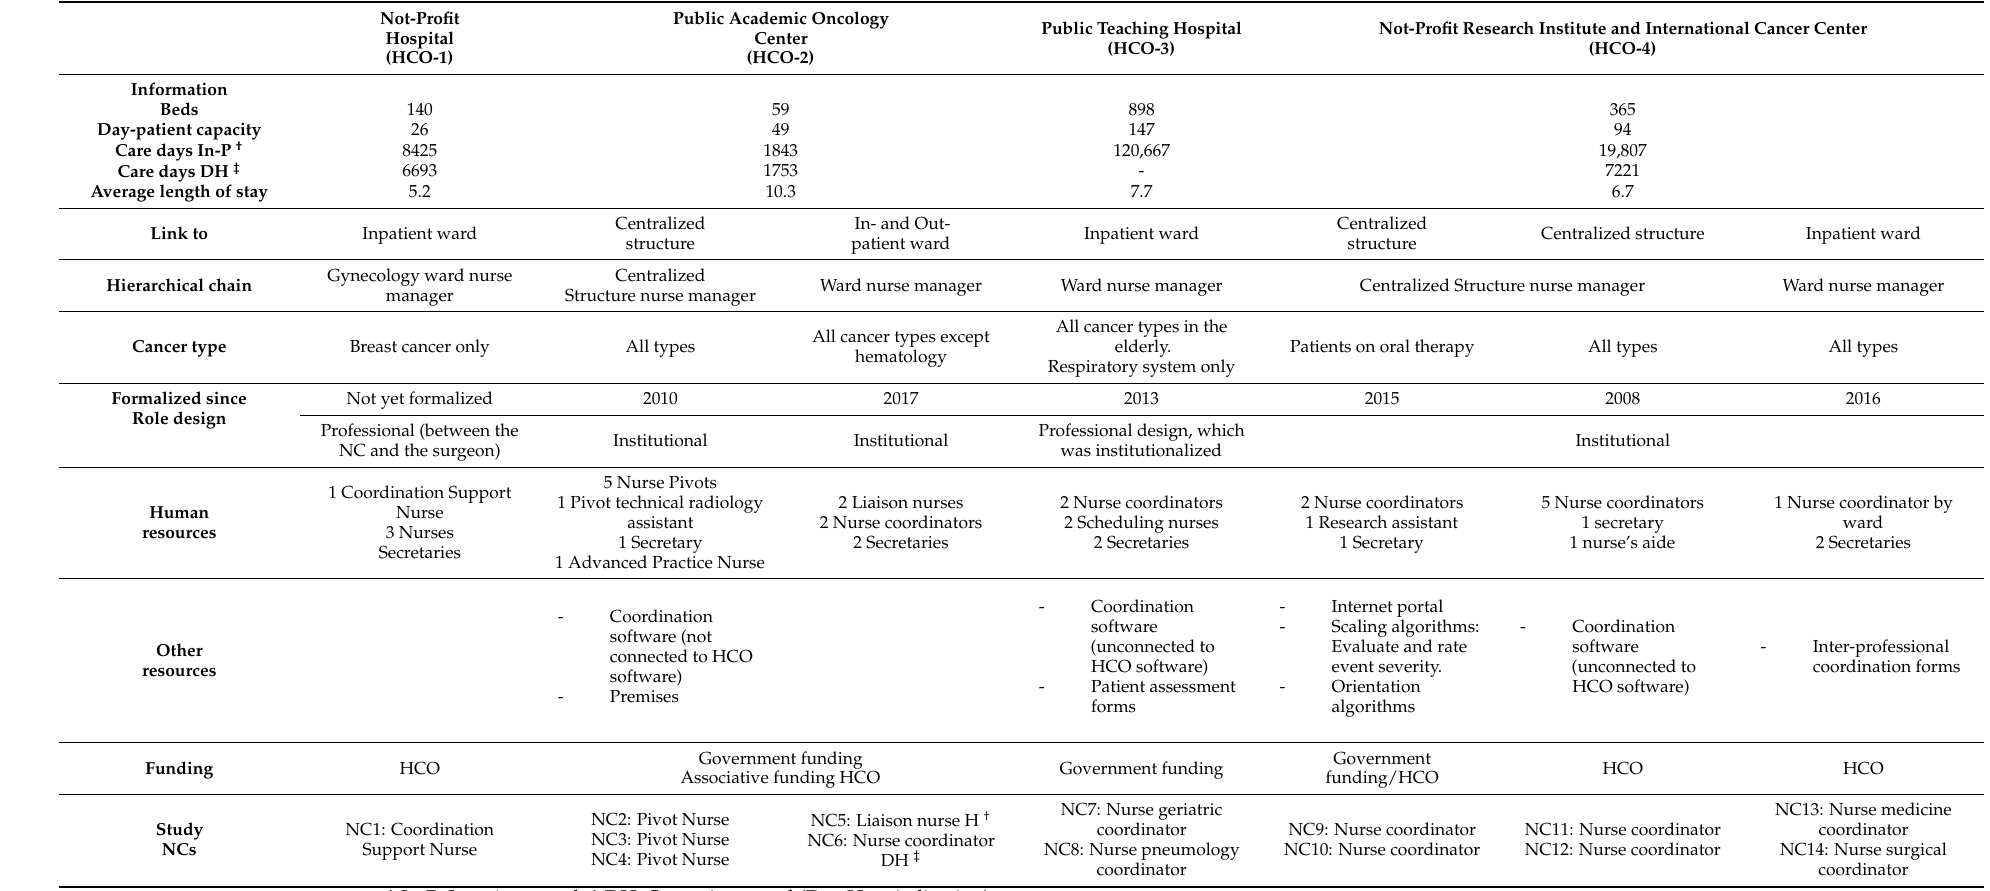
Table 1. Health Care Organization (HCO)